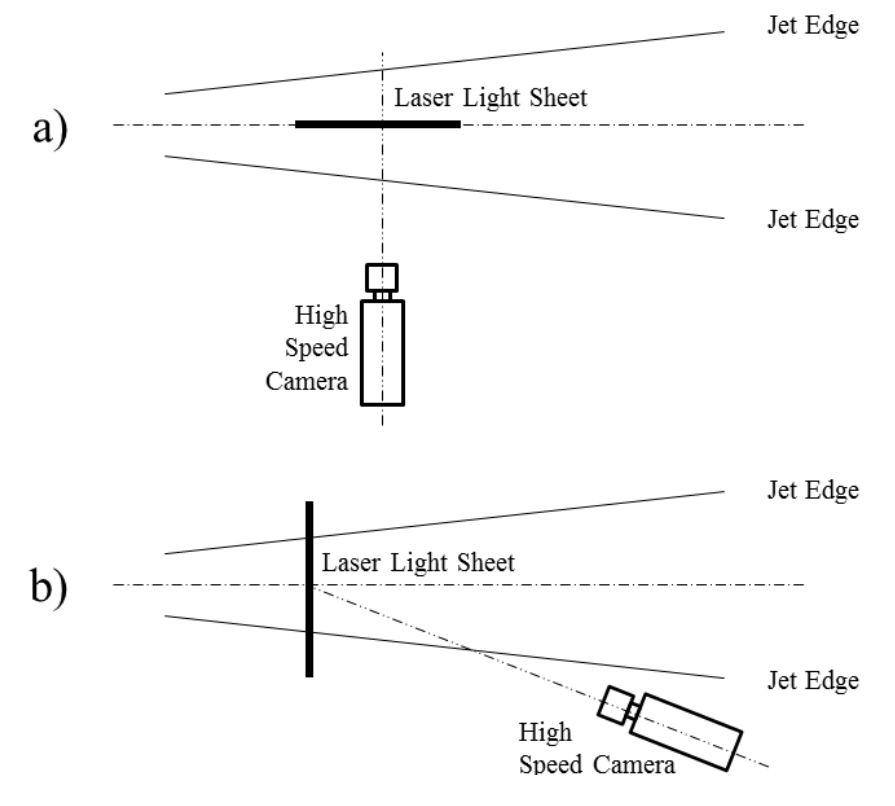
Figure 3. Top view of the laser sheet and camera placement for ( a ) longitudinal photos and ( b ) cross sectional